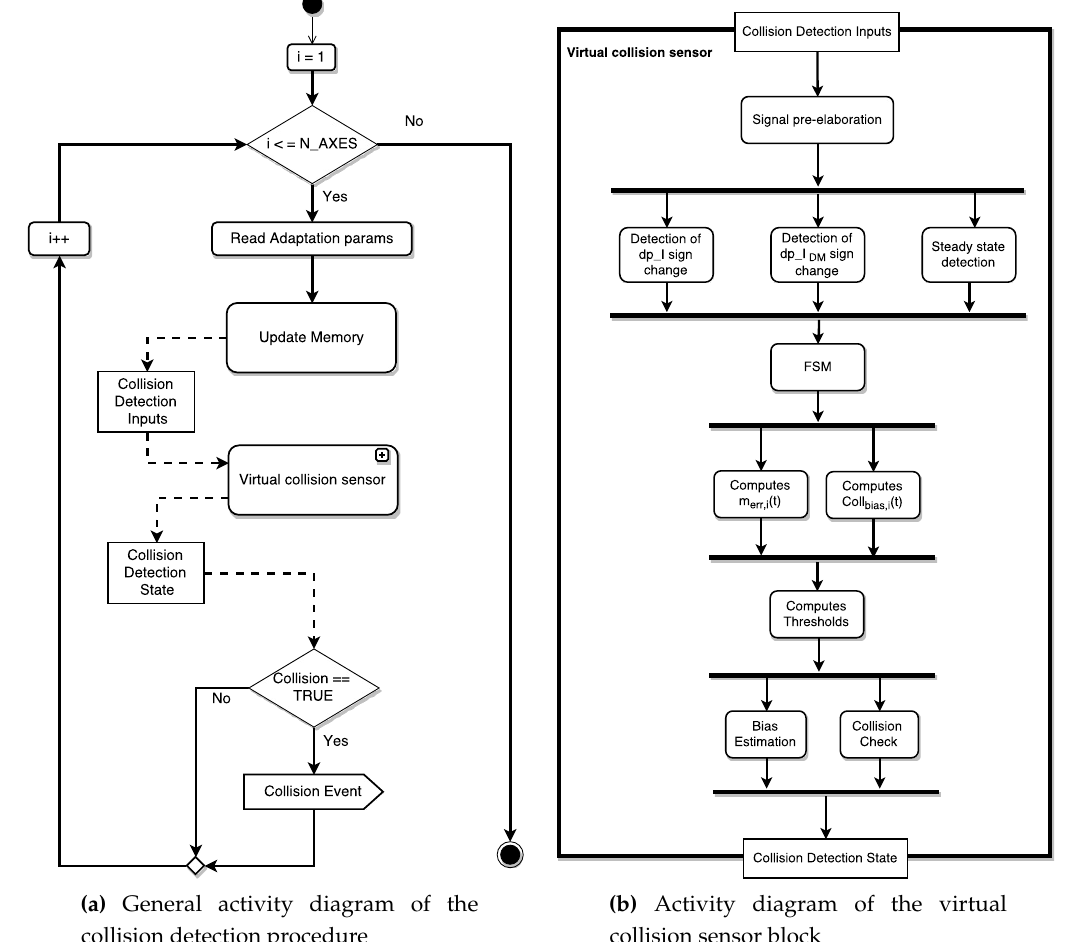
Figure 12. Overall activity